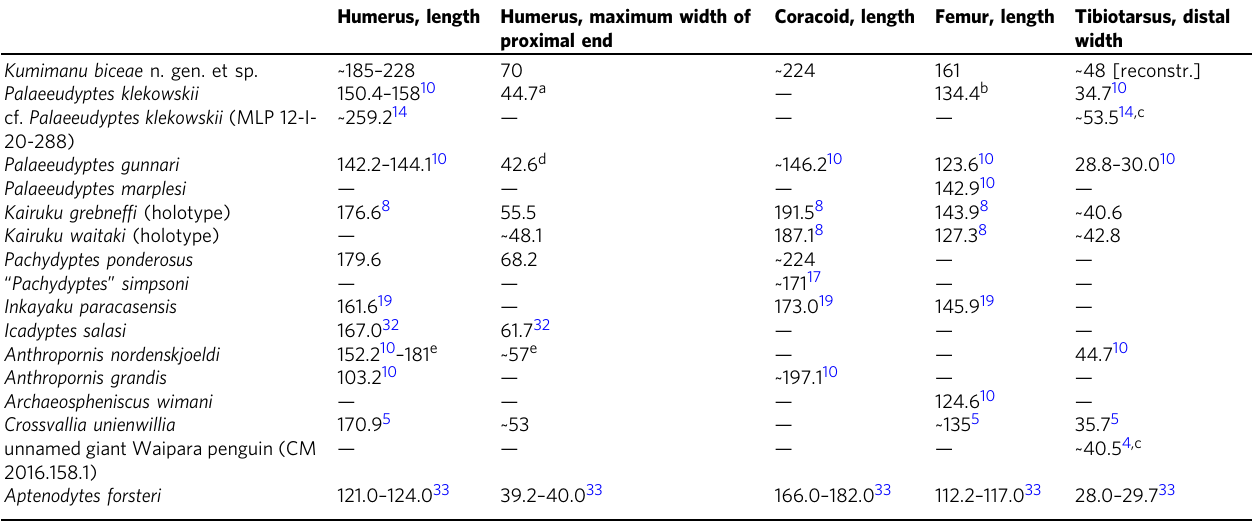
Table 1 Selected bone dimensions (in mm) of the new species and other Sphenisciformes Humerus, length Humerus, maximum width of Coracoid, length Femur, length Tibiotarsus, distal proximal end width Kumimanu biceae n. gen. et